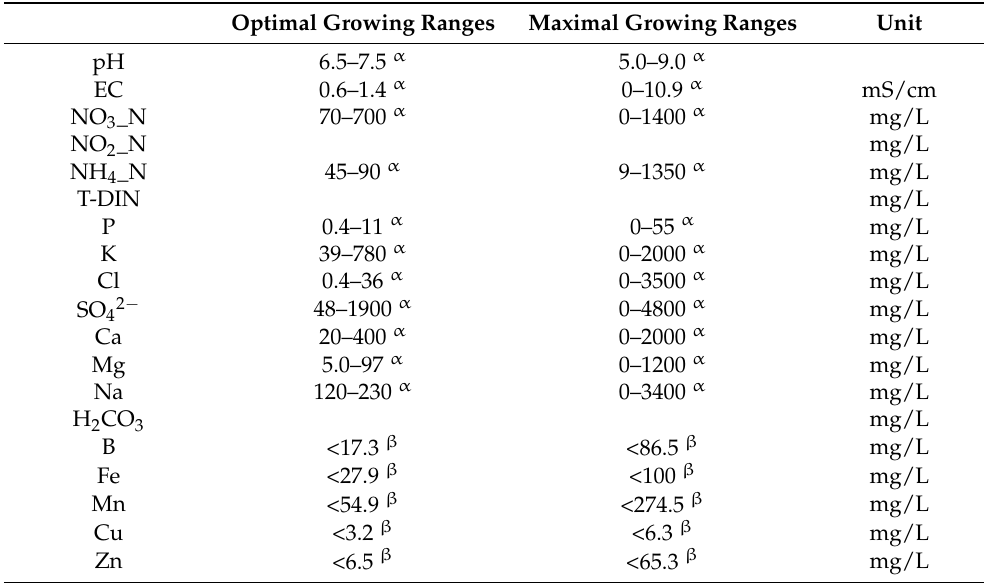
Table A3. Summary of the optimal and maximal growing ranges of Lemna minor , in which duckweed growth either is optimal or theoretically impossible [9,23].